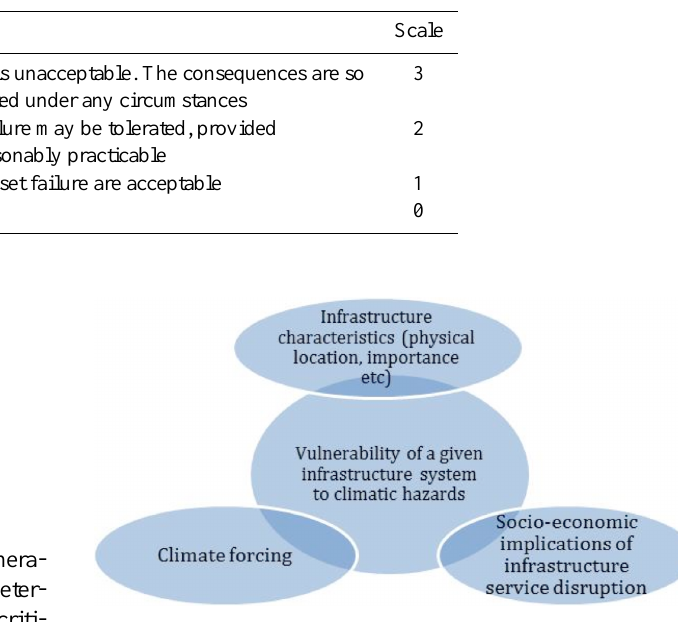
Figure 3. Vulnerability